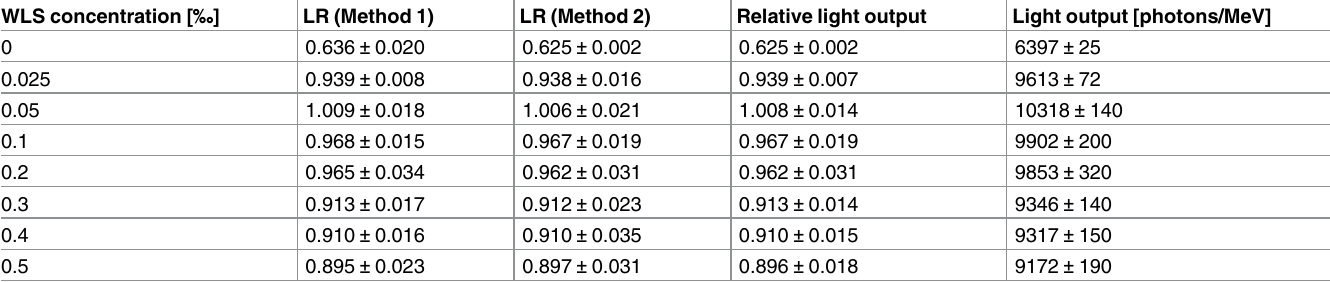
Table 1. Relative and absolute light output of the J-PET scintillators as a function of the WLS concentration. WLS concentration